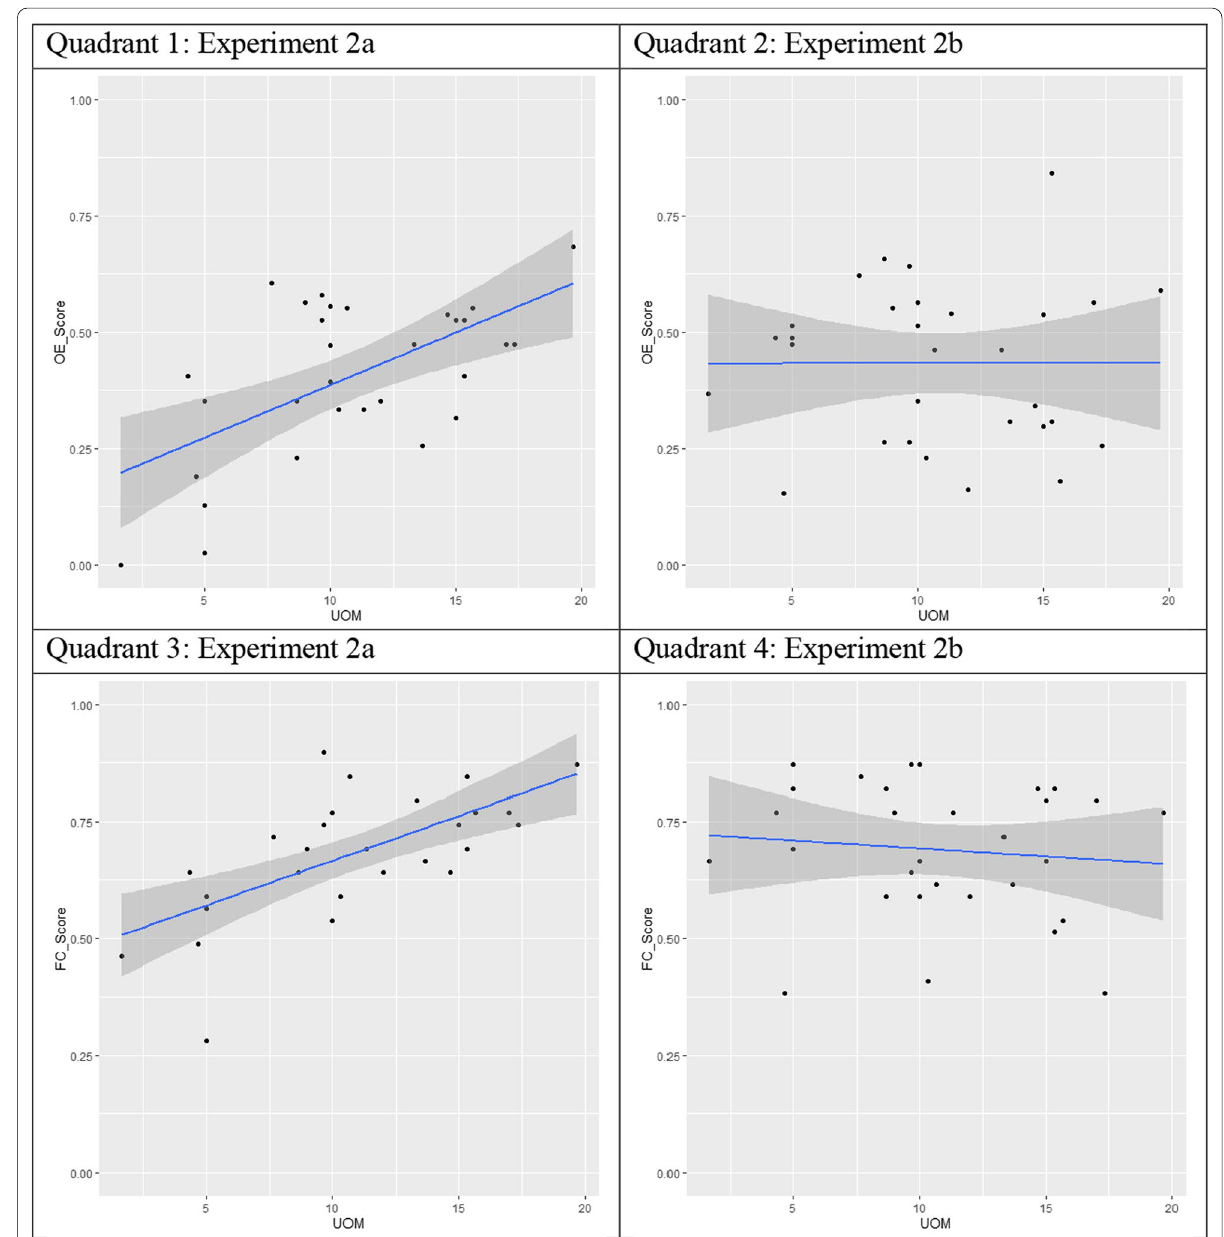
Fig. 5 Correct Units of Meaning (UOM) as predictors of open‑ended and forced‑choice performance in Experiment 2a (Retrieval Practice) and 2b (Restudy) . Note Graphs depicting relationship between correct units of meaning (UOM) retrieved (Retrieval Practice Condition; Experiment 2a) and restudied (Restudy Condition; Experiment 2b) and overall learning outcomes under both open‑ended (OE; Quadrants 1 and 2) and forced‑choice (FC; Quadrants 3 and 4) conditions, when controlling for word